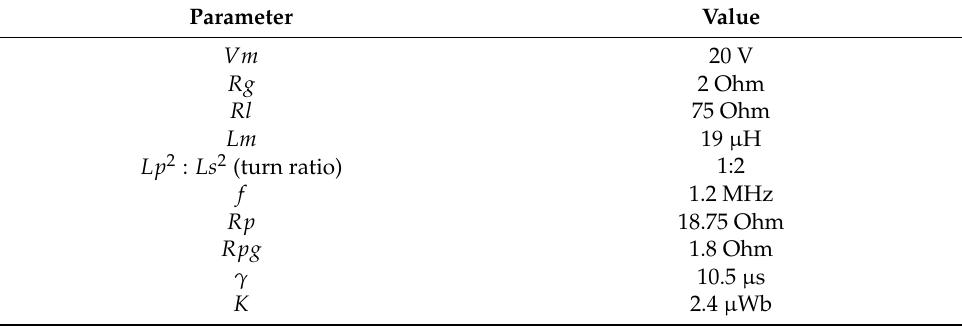
Table 1. Values of the components for the circuit of Figure 1.